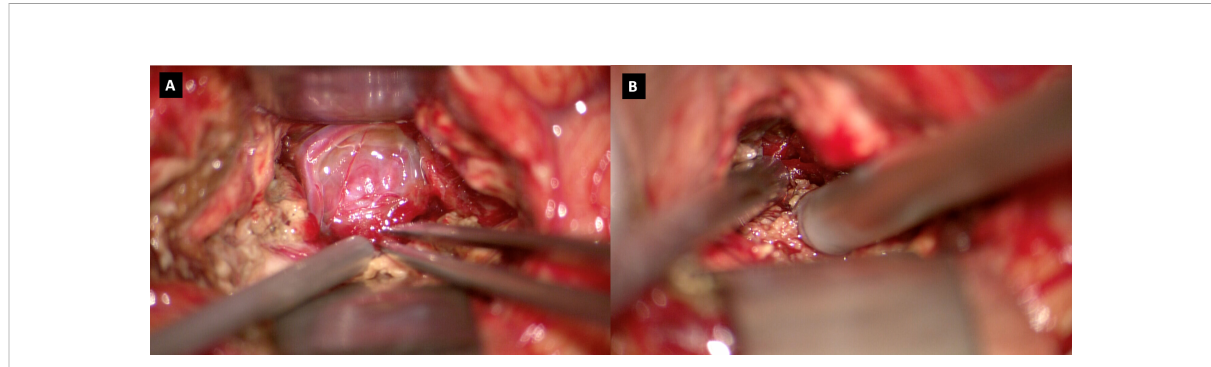
FIGURE 2 (A) Intraoperative visualization of the tumor, presenting as a hypervascularized mass in the tentorium hiatus; (B) Intraoperative use of in vivo confocal